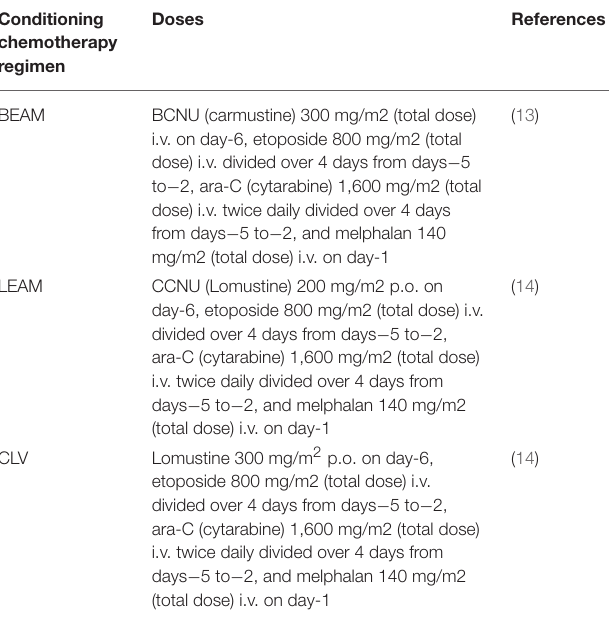
TABLE 1 | Baseline characteristics of the patients enrolled in the study. Characteristics